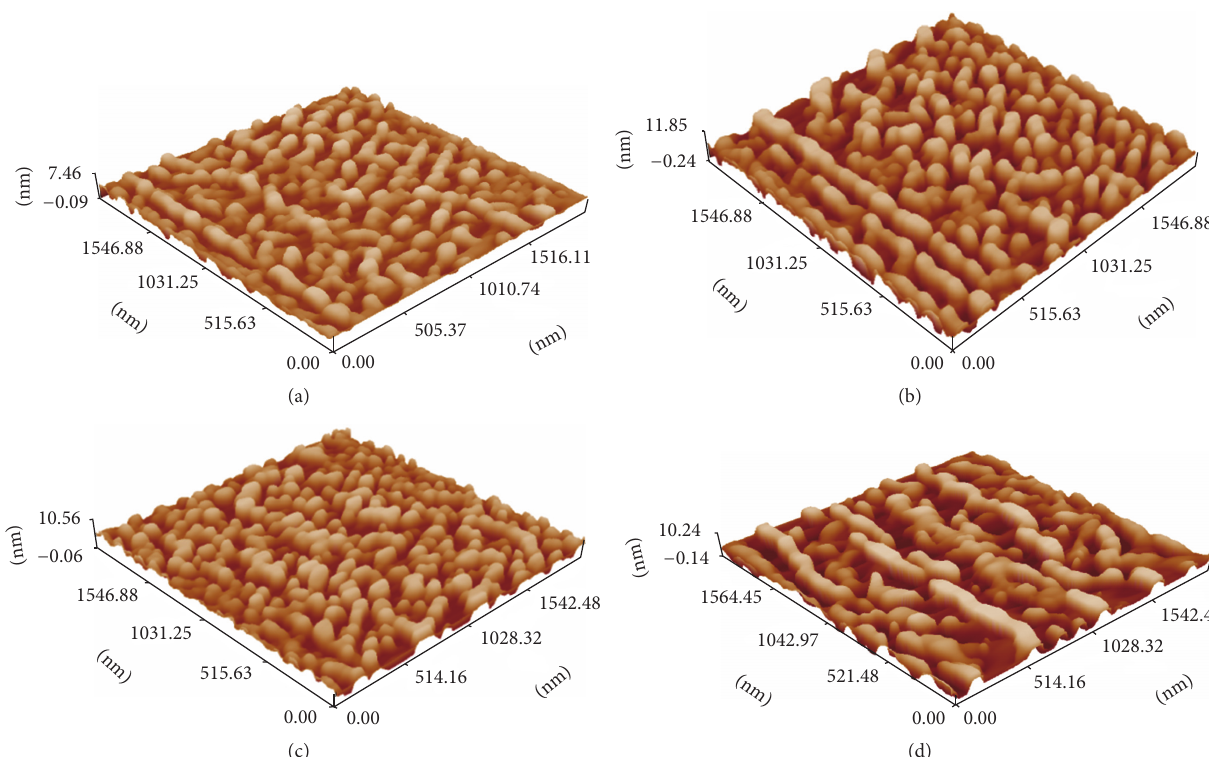
Figure 9: AFM images for Si of (a) 700 mJ, (b) 720 mJ, (c) 740 mJ, and (d) 760 mJ.